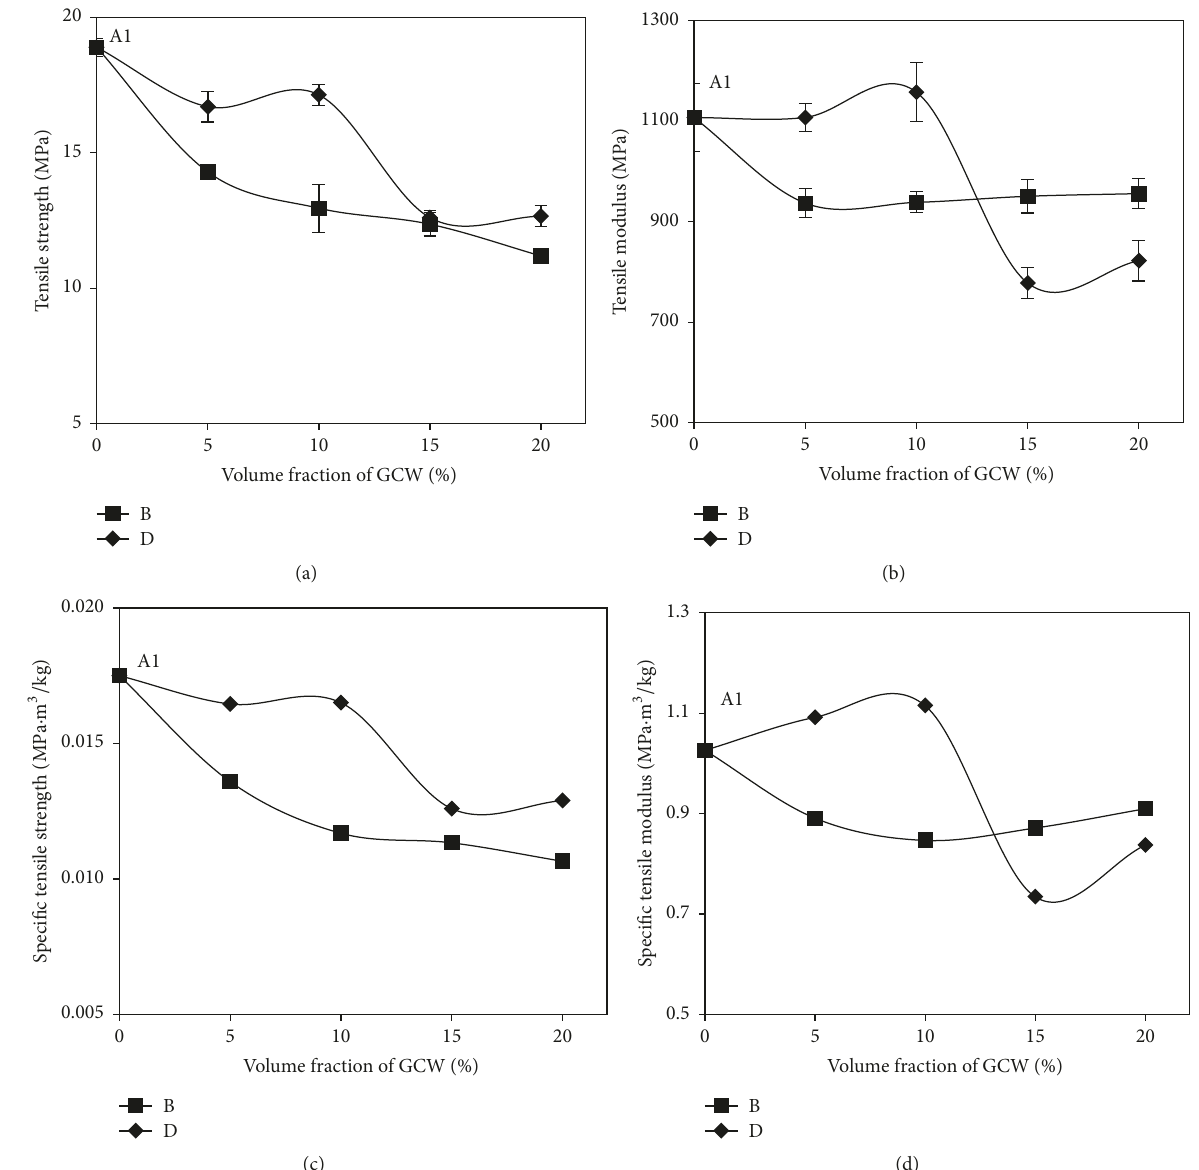
Figure 7: Effect of volume fraction of GCW on (a) tensile strength, (b) tensile modulus, (c) specific tensile strength, and (d) specific tensile modulus of composites types B and